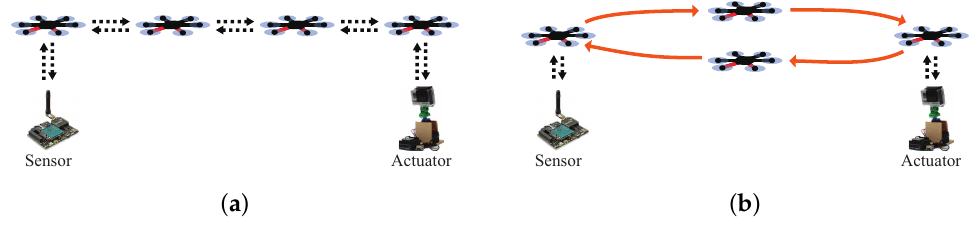
Figure 1. Two scenarios for the data transfer from the sensor. ( a ) multi-hop network method. ( b ) Data ferry method.